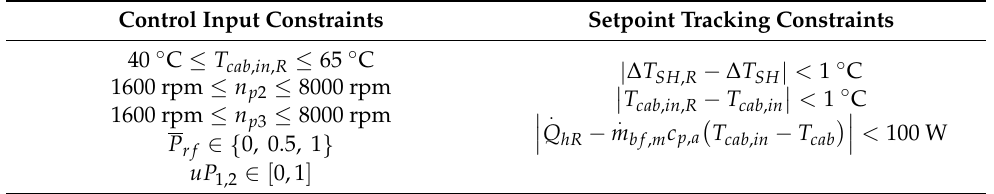
Table 1. Optimisation constraints. Control Input Constraints